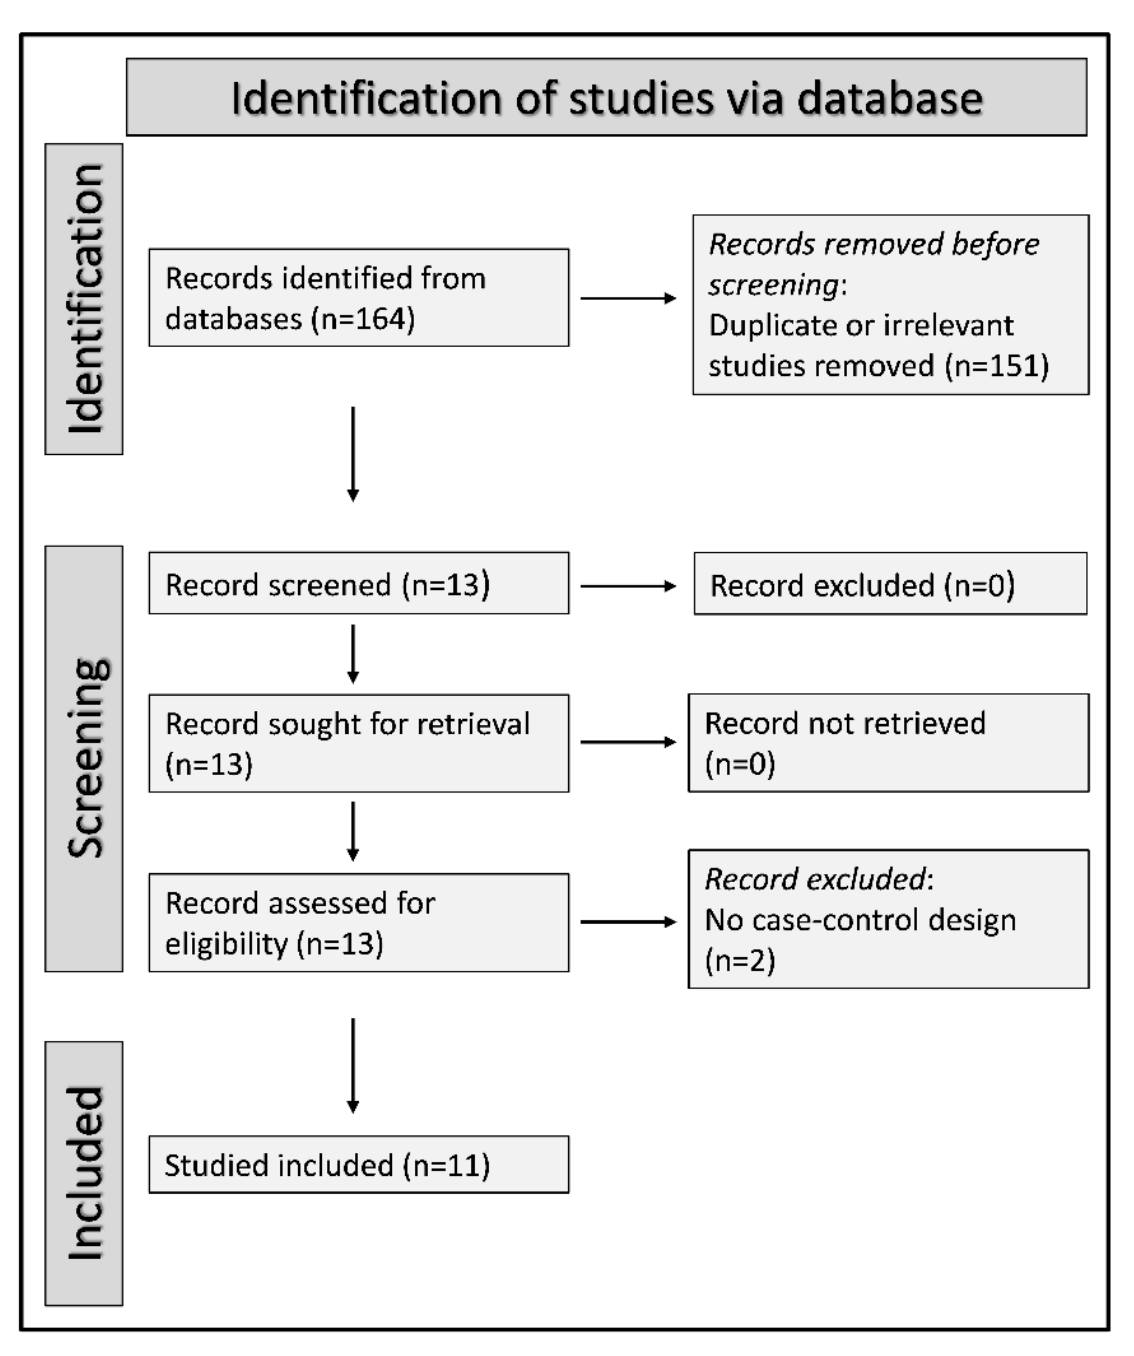
Figure 1. PRISMA 2020 flow diagram.